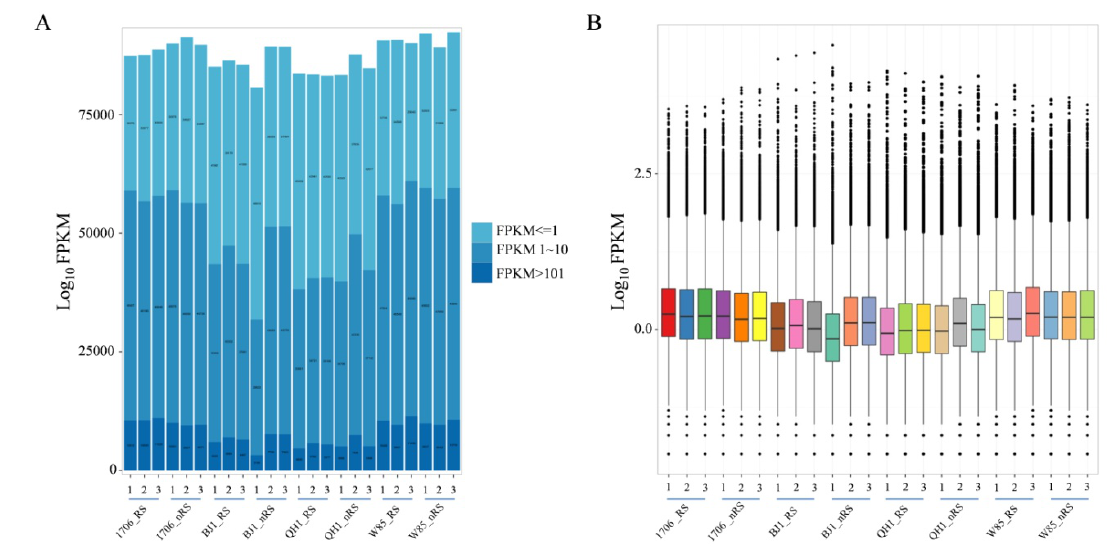
Figure 3. Unigenes expressed number and level on different tissues. ( A ) The number of expressed genes in each sample; ( B ) Expressional levels of unigenes of all the samples. Up and down lines of colored squares indicate upper and lower quartiles, and middle lines indicate medians. Black balls indicate outliers of expression values.